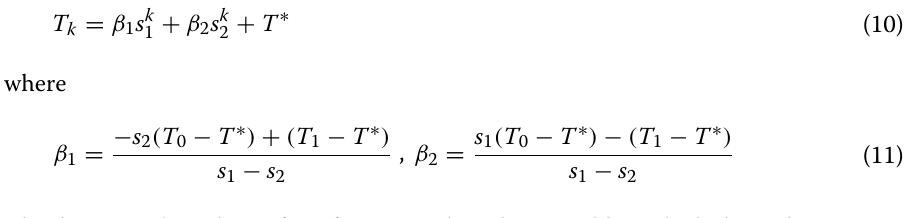
Fig. 1 In color the stability region of the fixed point T ∗ the eigenvalues are complex conjugate (resp.